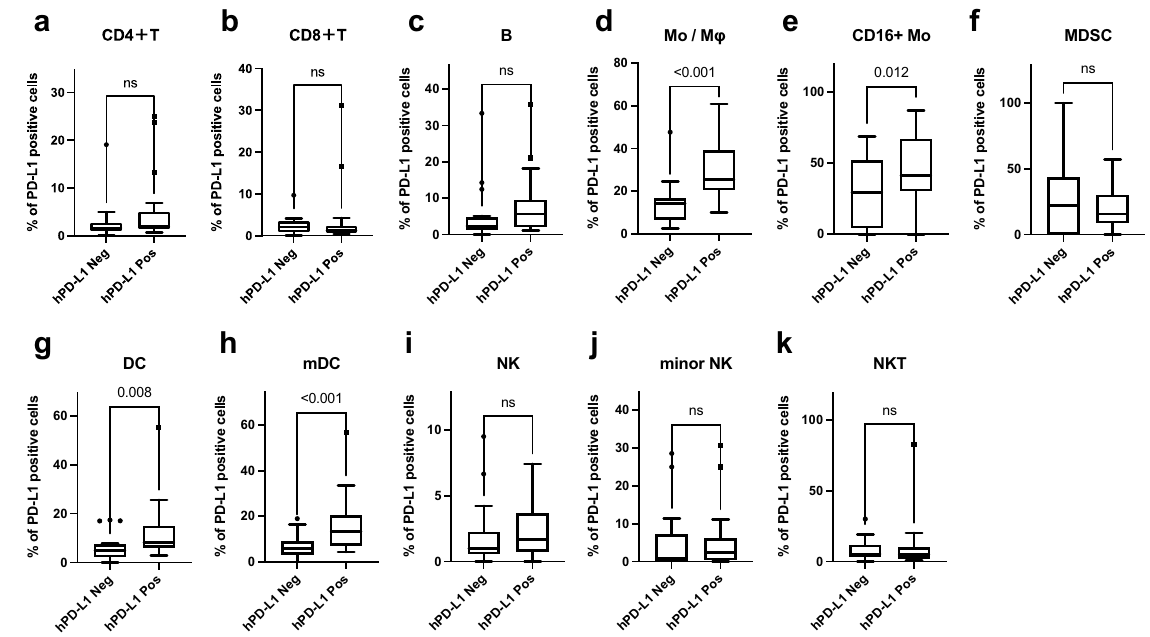
Figure 5. hPD-L1 positivity is associated with percentages of the PD-L1 positive cells in certain immune cell fractions. ( a – k ) For cases with tumor tissue samples, the percentages of PD-L1-positive cells in each immune cell fraction of the tumor tissues in the hPD-L1-negative and hPD-L1-positive cases were compared using the Mann–Whitney U test. The data are presented using Tukey box plots. Values of P < 0.05 are considered statistically significant. The actual P -values are presented in the